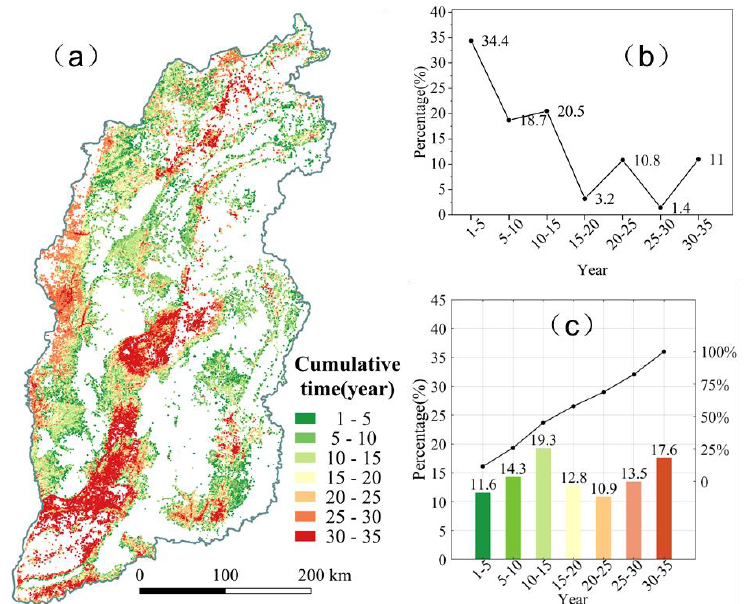
Figure 5. The spatial and temporal distribution of change processes: ( a ) spatial distribution of degradation; ( b ) the statistics of duration of degradation subsequences; ( c ) the statistics of cumulative time of